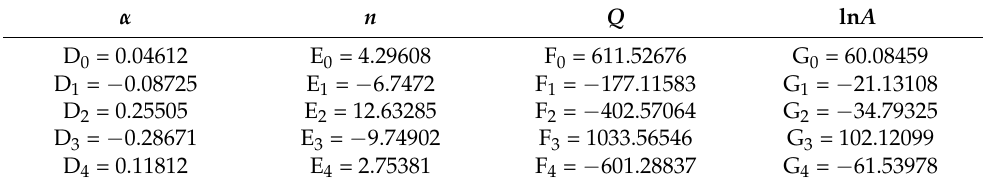
Table 3. Parameters of α , n, Q, and ln A at different strains in the α + β phase region. α n Q ln A